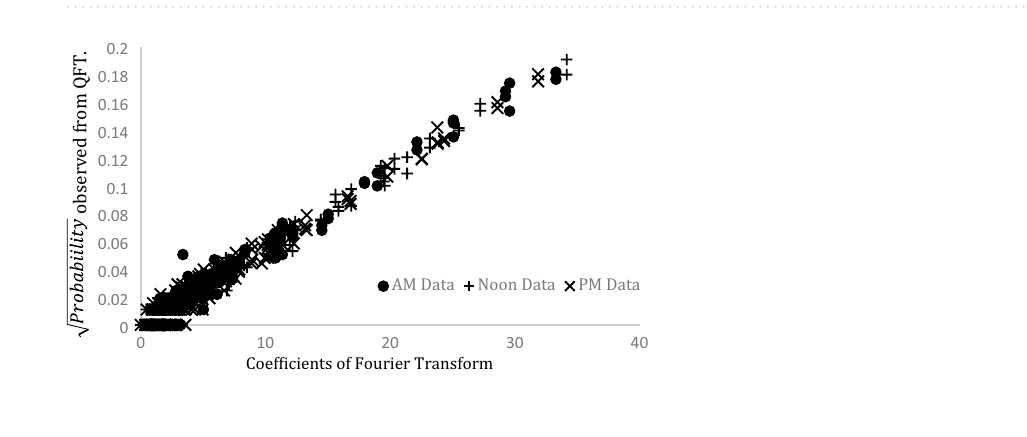
Figure 5. Comparison of the frequency domain based on calculations from QFT and Fourier transform.